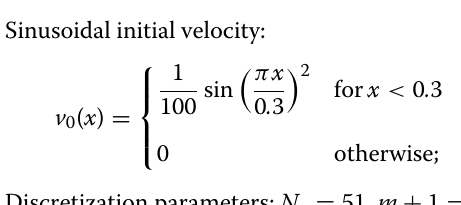
Figure 7 collects the space–time contour plot for the propagation of the elastic wave, for each κ ∈ K . The values in K have been selected in order to obtain solutions with a different level of detail in terms of behaviour at the microscale. Indeed, quantity κ can be easily related to the speed of the stress wave along the beam, after rewriting the differential equation in (23) as